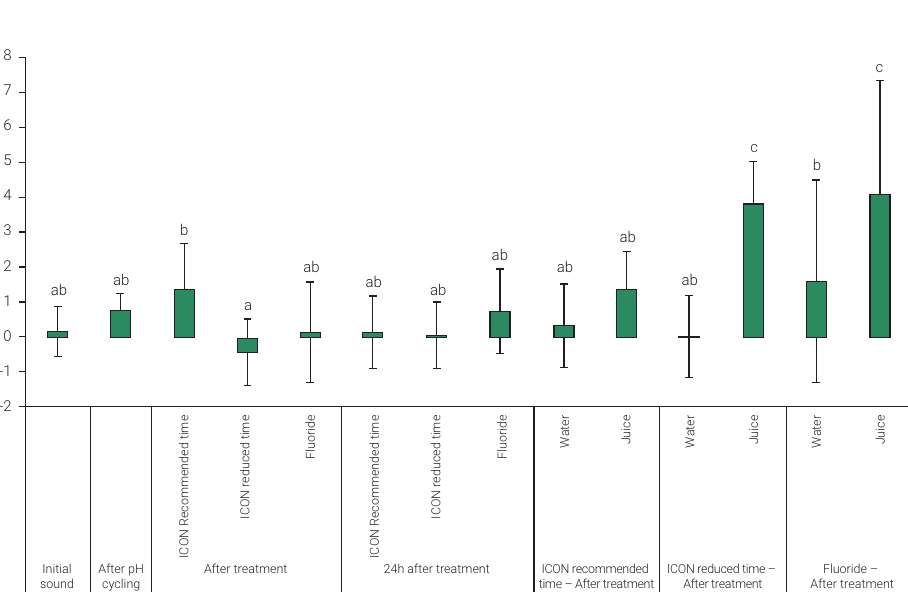
Figure 2. Graphic representation of a* mean values and standard deviations. Different letters indicate statistical significant difference (p < 0.05).